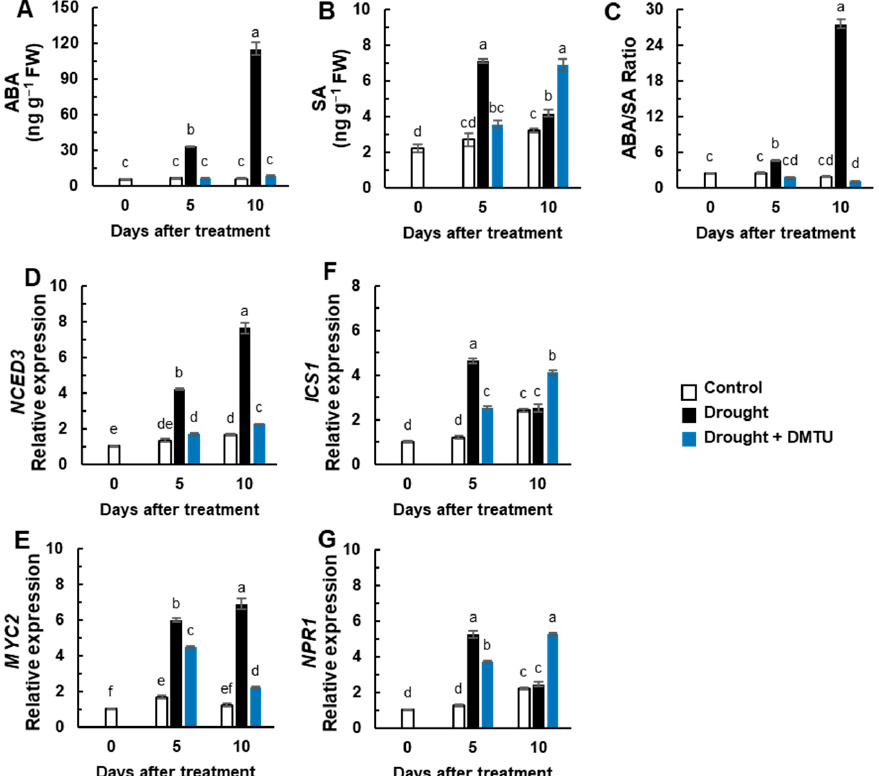
Figure 3. The changes in the levels of endogenous hormones and expression of hormone synthesis or signaling-related genes in the leaves of Brassica napus under control, drought, or drought with dimethylthiourea (Drought + DMTU) treatments for 10 days. ( A ) abscisic acid (ABA) and ( B ) salicylic acid (SA) concentrations, and ( C ) the ratio of ABA to SA. The expression of the ( D ) ABA synthesis-related gene NCED3 , ( E ) ABA signaling-related gene MYC2 , ( F ) SA synthesis-related gene ICS1 , and ( G ) SA signaling-related gene NPR1 . The transcriptional levels in control plants at day 0 were set to 1. Results are represented as mean ± SE for n = 3. Means with different letters are significantly different at p < 0.05, according to Duncan’s multiple range test.